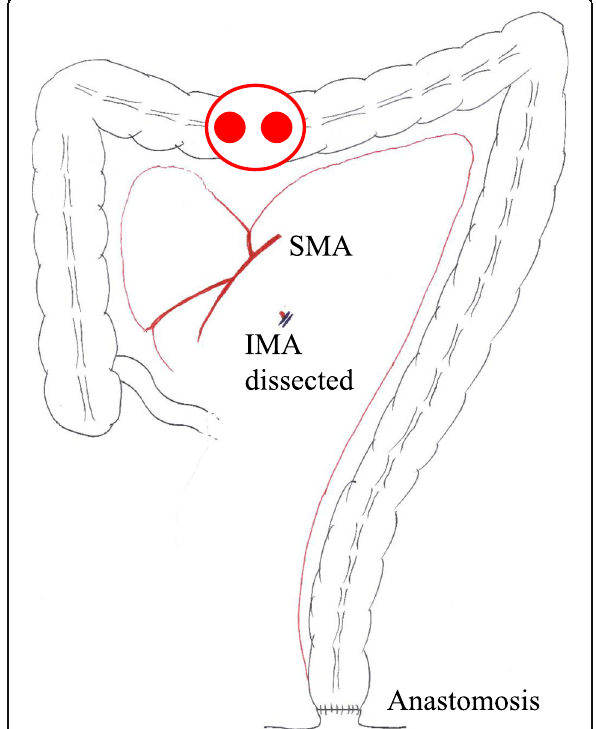
Fig. 5 Emergency surgery of transverse colostomy creation was